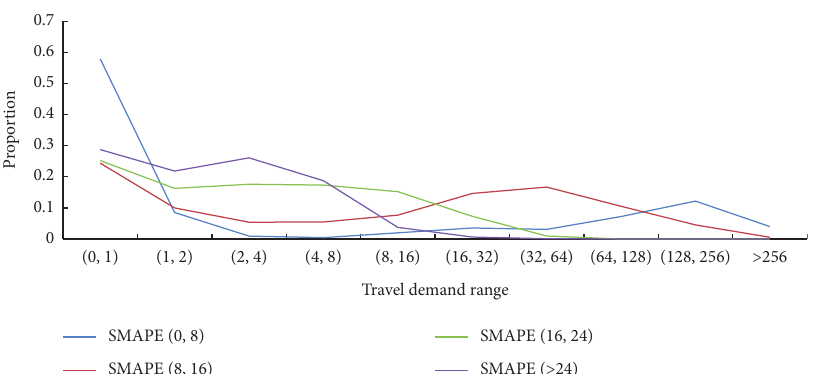
Figure 6: Composition of travel demand in different SMAPE hexagon partitions.